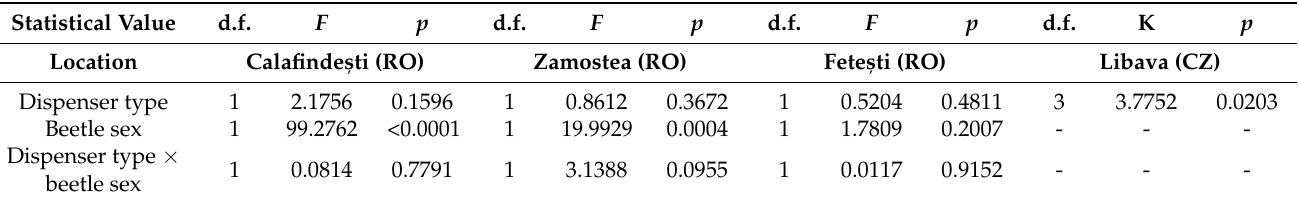
ti, Zamostea and Fetes ti, and Kruskal-Wallis for Libava). , ,